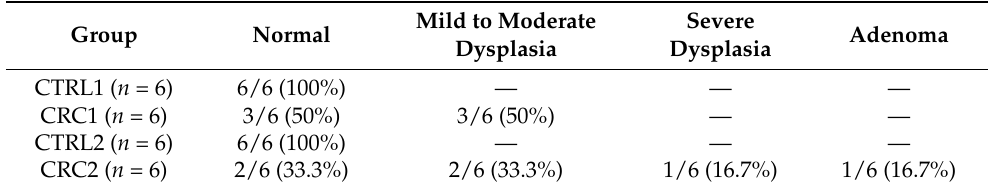
Table 5. Incidence of histopathological proliferative lesions observed in rats’ colon. The percentage represents the number of animals with injury per total number of animals in the group. Mild to Group Normal